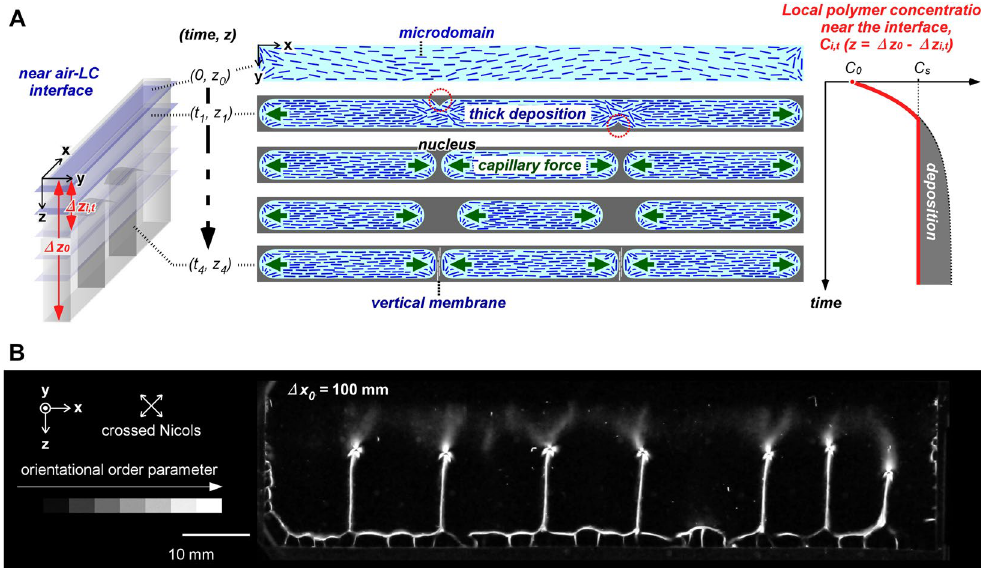
Figure 5. Macro-space partitioning via membrane walls in top-side-open cell. ( A ) Schematic illustrations of cross-sectional views in the XY -plane near the air-LC interface, and the change in polymer concentration in time course. When the concentration is saturated at the interface, the polymer is deposited at several specific points as thick nuclei on the walls. These points grow into a link between the slides, and the capillary force enhances the formation of vertical membranes. C 0 : initial concentration; C S : saturated concentration; C i,t : local polymer concentration near the interface in a partitioned space i at time t . ( B ) Macro-space partitioning by multiple vertical membranes dried in limited space with X -width, ∆ x 0 = 100 mm. The Y -thickness is ∆